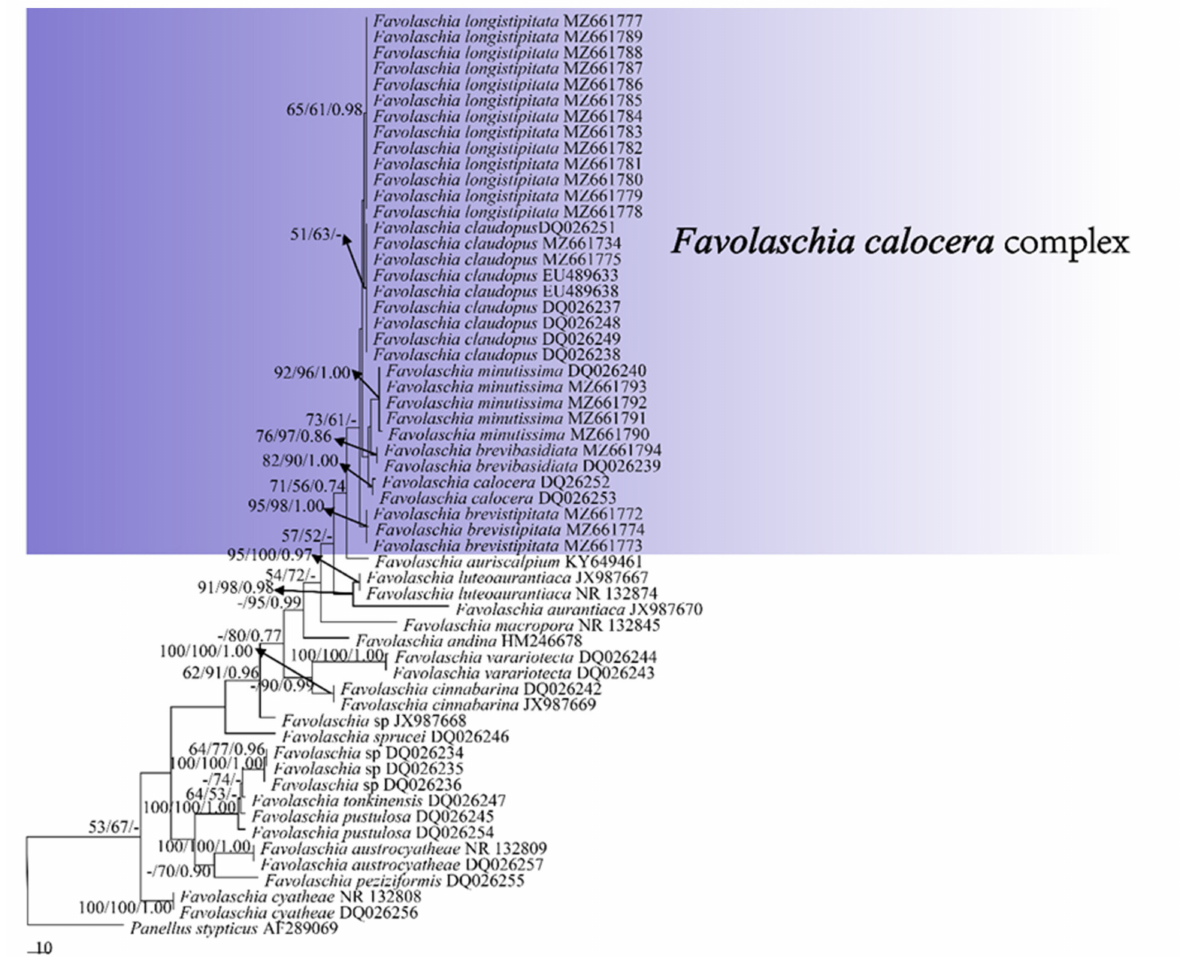
Figure 1. Maximum parsimony tree illustrating the phylogeny of the Favolaschia calocera complex and related group based on the combined sequences dataset of ITS. Branches are labelled with parsimony bootstrap values higher than 50%, and Bayesian posterior probabilities more than